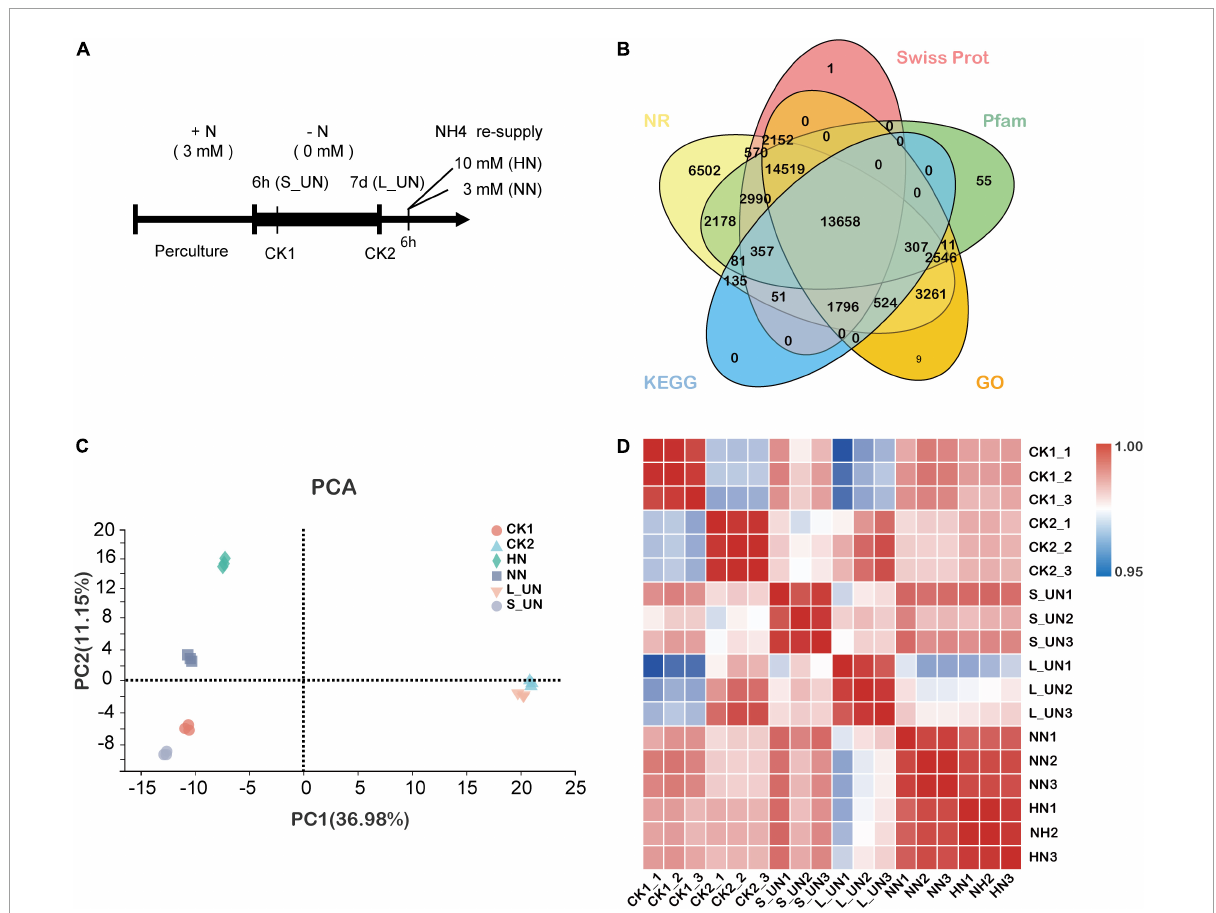
FIGURE1 Experimental design and transcriptome relationships. (A) Schematic representation of the experimental design. After preculture, tea plants were transferred to N-deficient media (0 mM) for 6 h (S_UN) or 7 days (L_UN) or maintained in N-sufficient solution for 7 days (CK2). After treatment for 7 days, the N-starved plants were supplied with normal (NN) or high NH 4 + (HN) media for up to 6 h. (B) Public gene expression databases. Each database is labeled with a colored oval. (C) Principal component analysis (PCA) of 18 RNA-Seq samples from “Longjing 43.” Each shape represents a different time point. (D) Pearson correlation coefficients of all samples